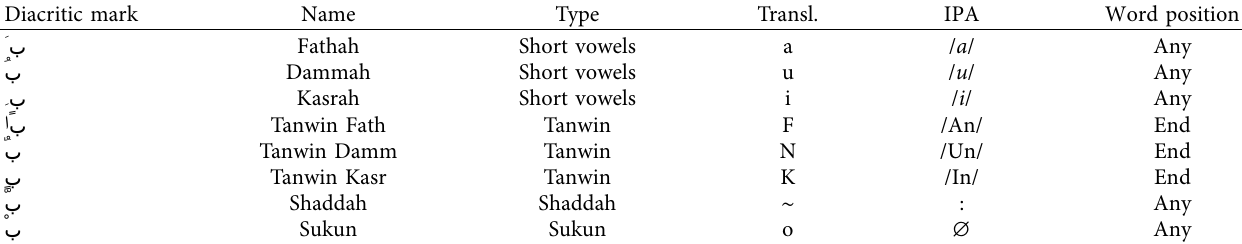
Table 1: Arabic diacritics with their International Phonetic Alphabet representation (IPA). Diacritic